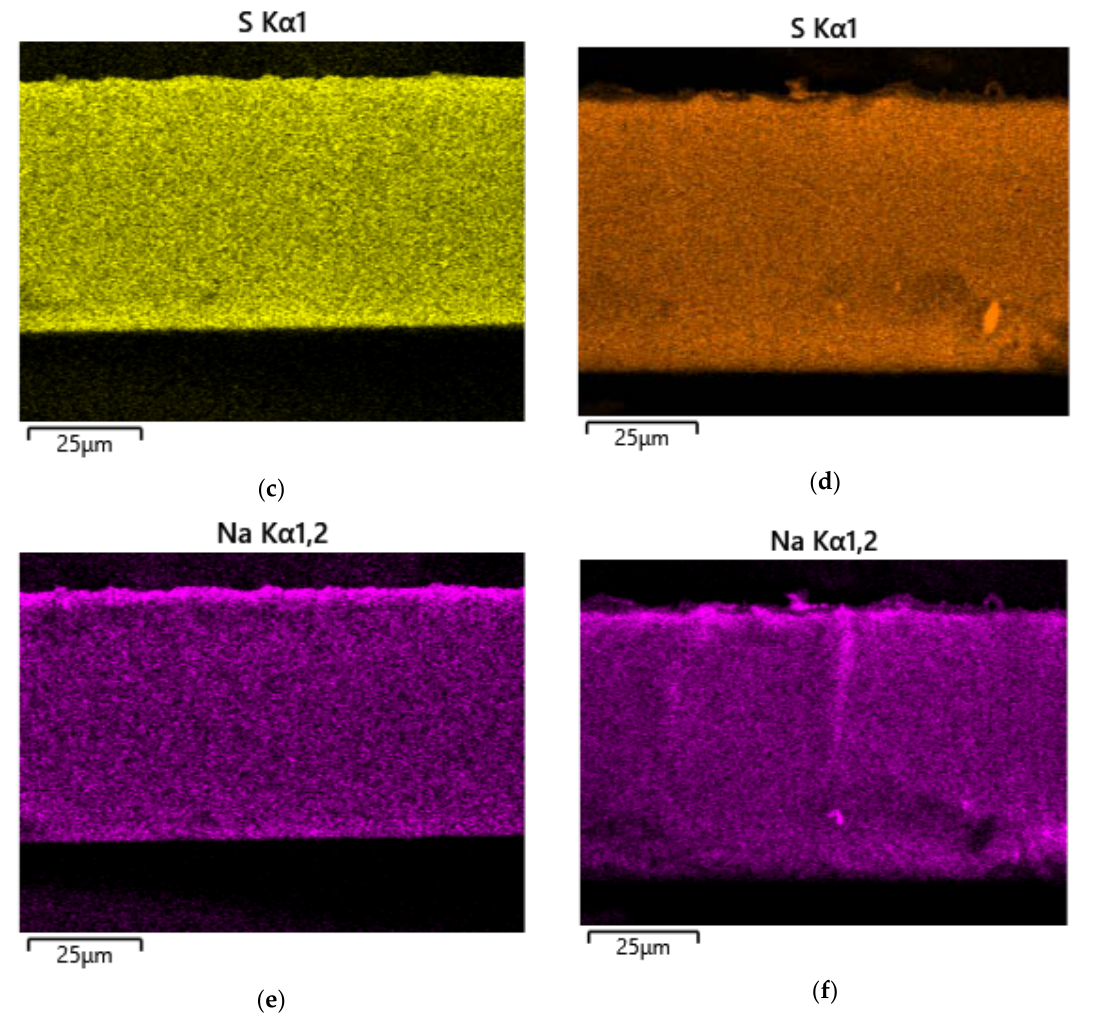
Figure 2. SEM micrographs of the cross-section of MCG-0 ( a ) and MCG-3 ( b ) membrane, as well as distribution of S ( c , d ) and Na ( e , f ).